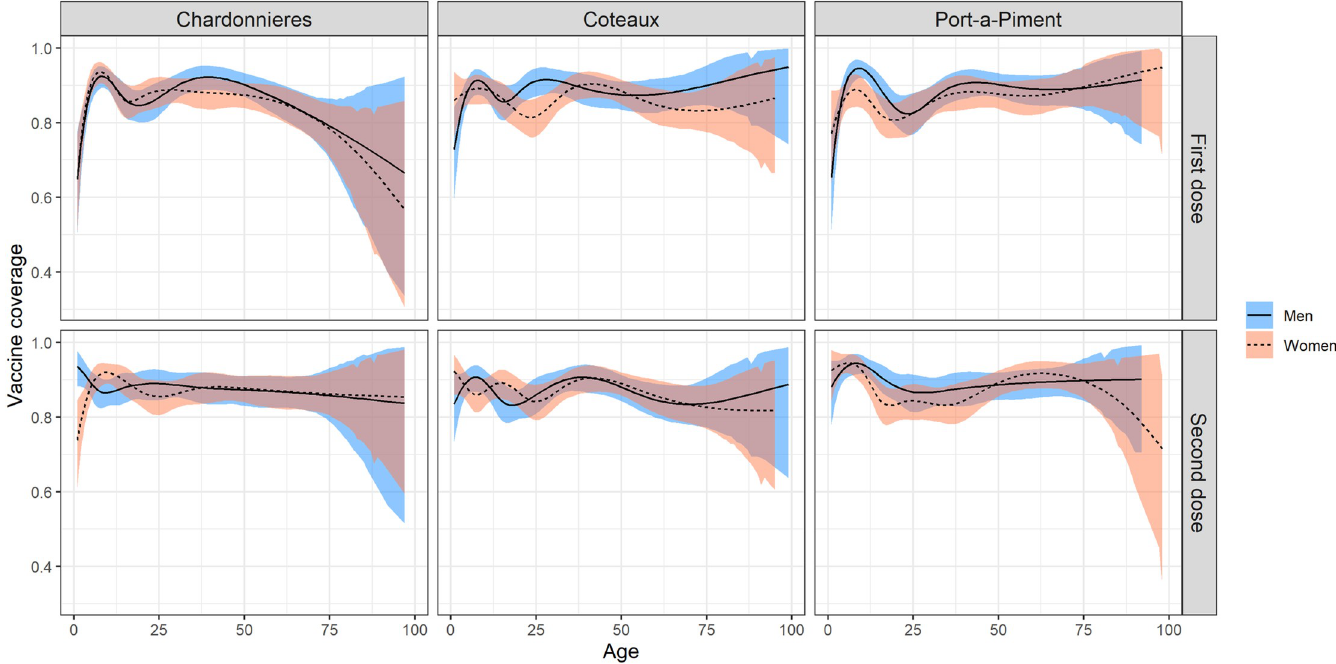
Fig 2. Self-reported cholera vaccination coverage by Commune, age and gender, South Department, Haiti, 2017. https://doi.org/10.1371/journal.pntd.0007967.g002 PLOS NeglectedTropical Diseases | https://doi.org/10.1371/journal.pntd.0007967 January 31,